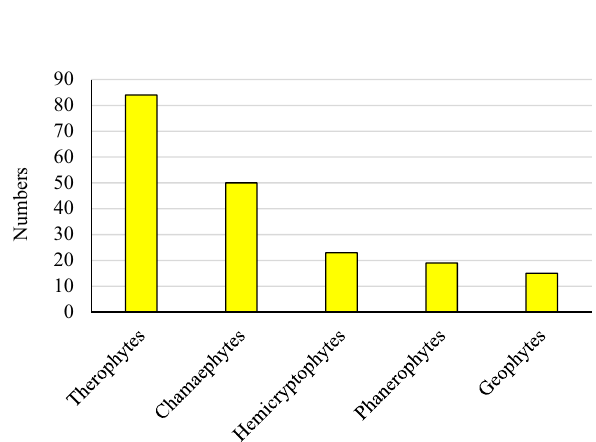
Figure 5. Total life form numbers recorded in all the study areas.